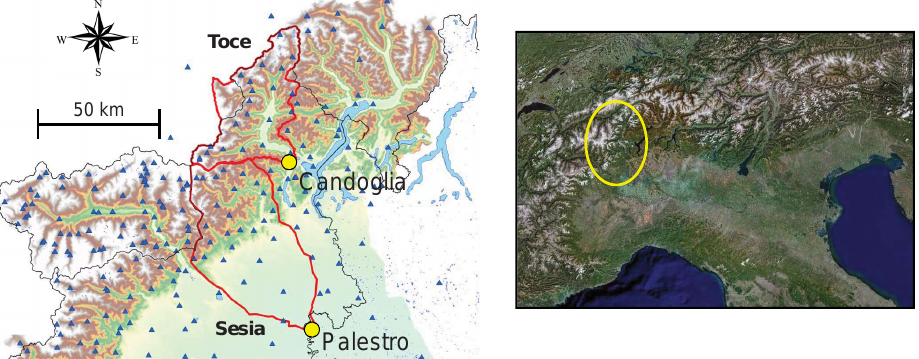
Fig. 1. Digital elevation model (DEM) of the area in the study. On the left side, the boundaries of each basin are shown in bold red, watershed gauging stations are illustrated with yellow dots, and rain gauges in blue triangles.